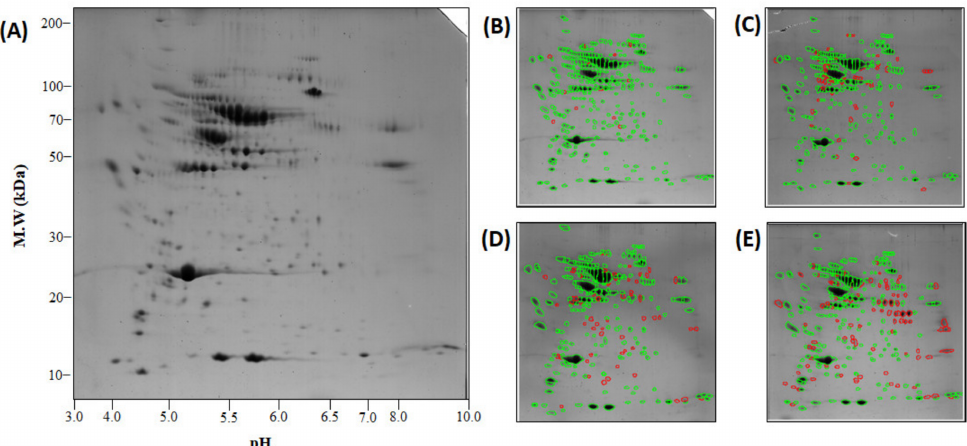
Figure 6. The reference two-dimensional gel electrophoresis (2DE) gel of the plasma in this study. One milligram of protein was separated by isoelectric focusing (IEF) and molecular weight (Mw) ( A ). A representative 2DE gel for control (Con) ( B ), 4 ( C ), 24 ( D ), and 72 ( E ) hpt is shown. All 2DE results and spot ids are available in Table S6. The spots are covered by green and red lines to indicate pair and non-pair spots, respectively.